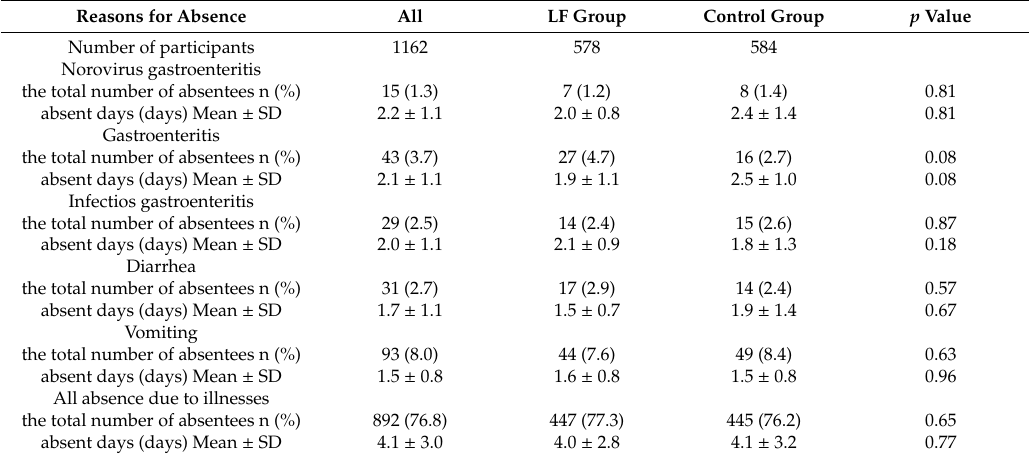
Table 2. The numbers of absentees and absen days in the LF group and the Control